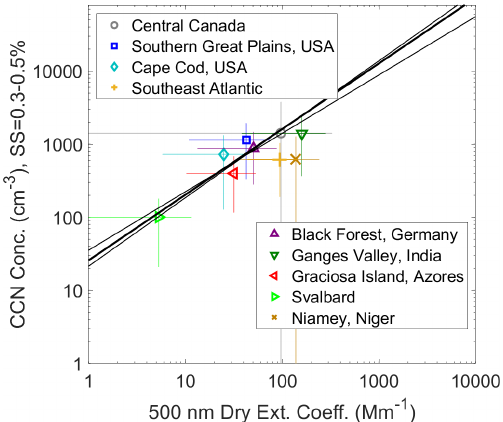
Figure 7. Adapted from Fig. 6 in Shinozuka et al. (2015), campaign-average in situ CCN concentration and in situ dry extinc- tion at 500nm are overlaid, using the label “Southeast Atlantic”. The error bars are calculated using standard deviation, and the origi- nal best-fit lines have not been altered. The supersaturation for these observations ranges from 0.3%–0.5% to match the analysis done in Shinozuka et al.